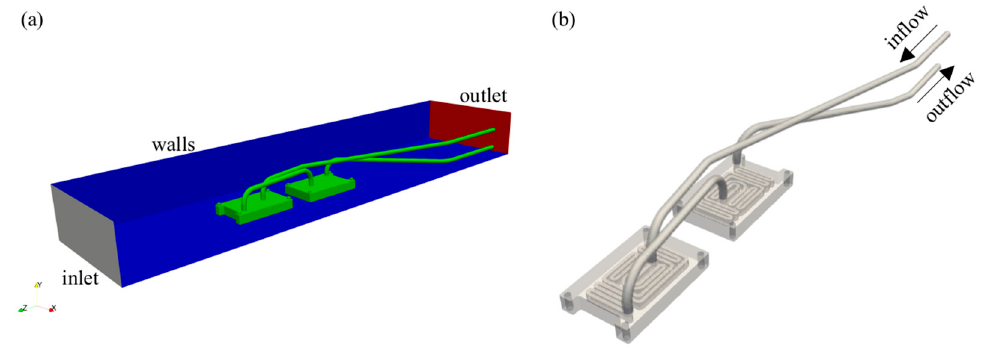
Figure 9. ( a ) Three-dimensional view of the computational domain and boundaries, ( b ) cold plate design.